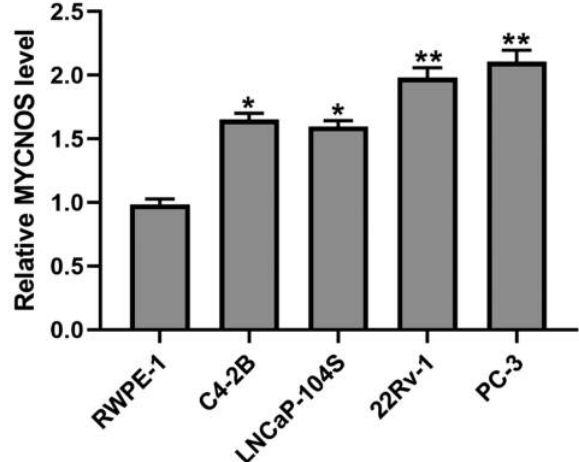
Figure 2. Upregulation of MYCNOS was observed in PC cell lines. MYCNOS expression in 22Rv-1, C4-2B, LNCaP-104S, PC-3, and non-tumorigenic cell line RWPE-1 was determined by RT-qPCR. * p < 0.05 and ** p < 0.01 vs RWPE-1.